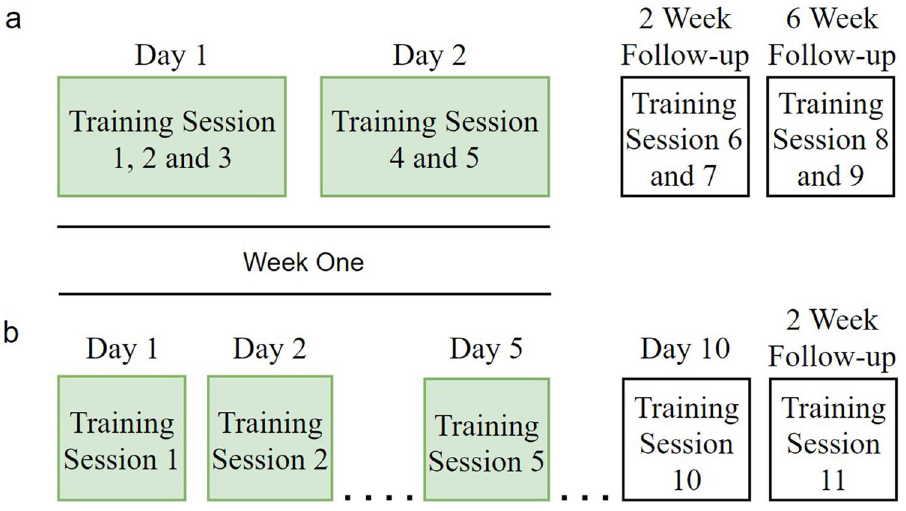
Figure 1. Cognitive Training Schedule for the daily group ( a ) and intensive group ( b ). Green background: cognitive training sessions included in the current analysis ce check ms and